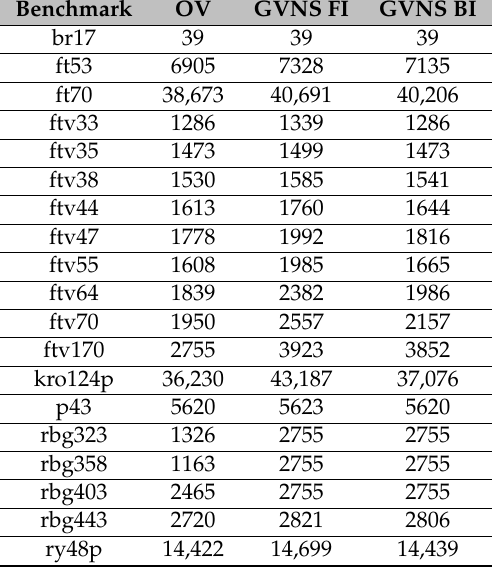
Table 5. GVNS on asymmetric TSPs.